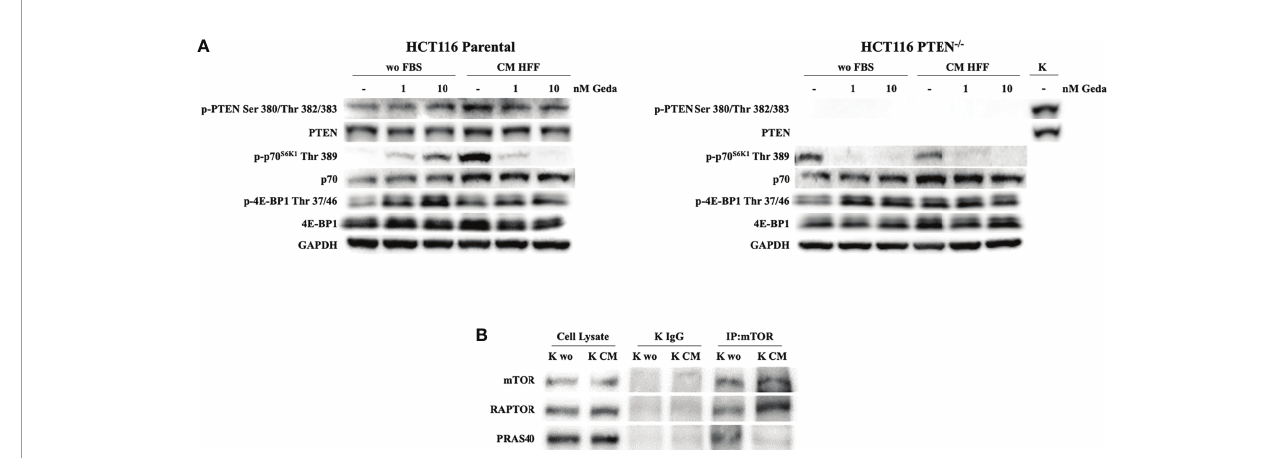
FIGURE 3 | Evaluation of PI3K pathway activation in response to Geda in the presence of fi broblast-derived CM. (A) HCT1116 Parental and HCT116 PTEN -/- cell lines were treated with 1 and 10 nM of Geda in serum-free condition and HFF-CM. Cells were lysed and analyzed by Western Blotting using speci fi c antibodies (as indicated). GAPDH is shown as protein loading and blotting control. (B) HCT116 Parental cells were grown in wo FBS and HFF CM for 24 h. Endogenous mTOR was immunoprecipitated (IP:mTOR) and the immunocomplexes were blotted for RAPTOR and PRAS40. mTOR, RAPTOR and PRAS40 levels in total cell lysates are also shown. Results of a representative experiment out of three independent experiments performed are